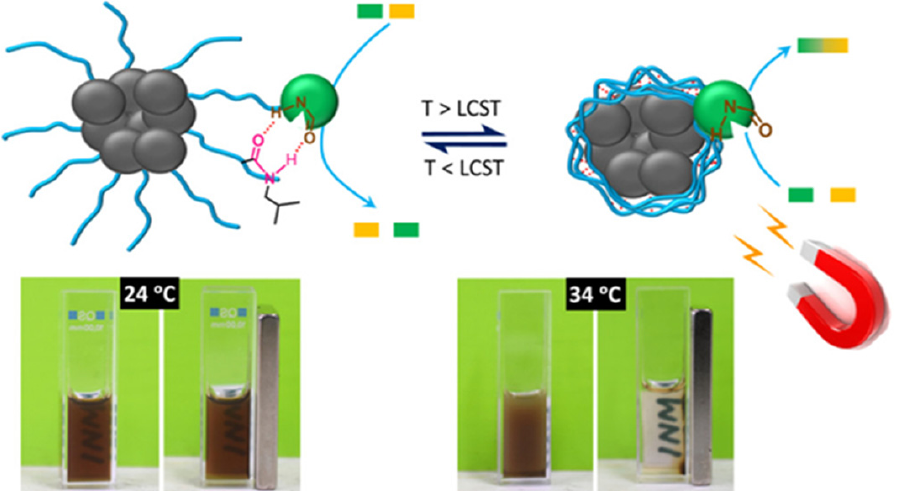
Figure 2. Schematic representation of the biocatalyst formed from magnetic NP clusters coated with a thermally responsive brush with attached enzyme. LCST stands for the lower critical solution temperature, while INM is the abbreviation of the Institute for New Materials (authors’ affiliation).